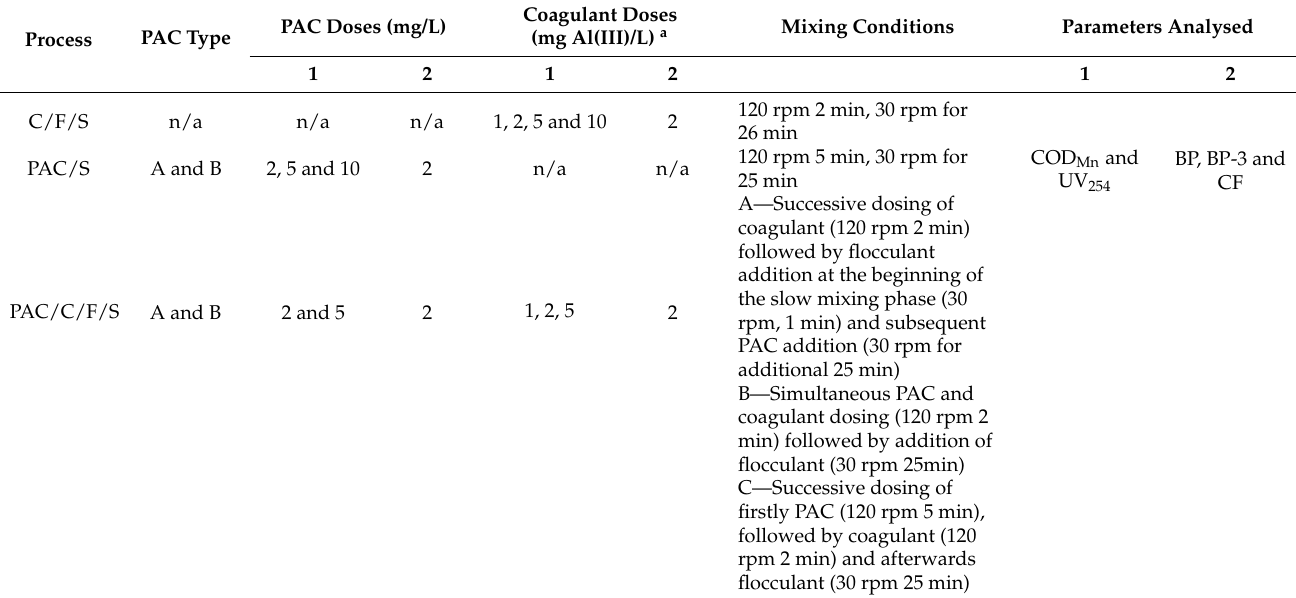
Table 4. Experimental conditions for separate C/F/S and PAC /S and hybrid process of PAC/C/F/S.